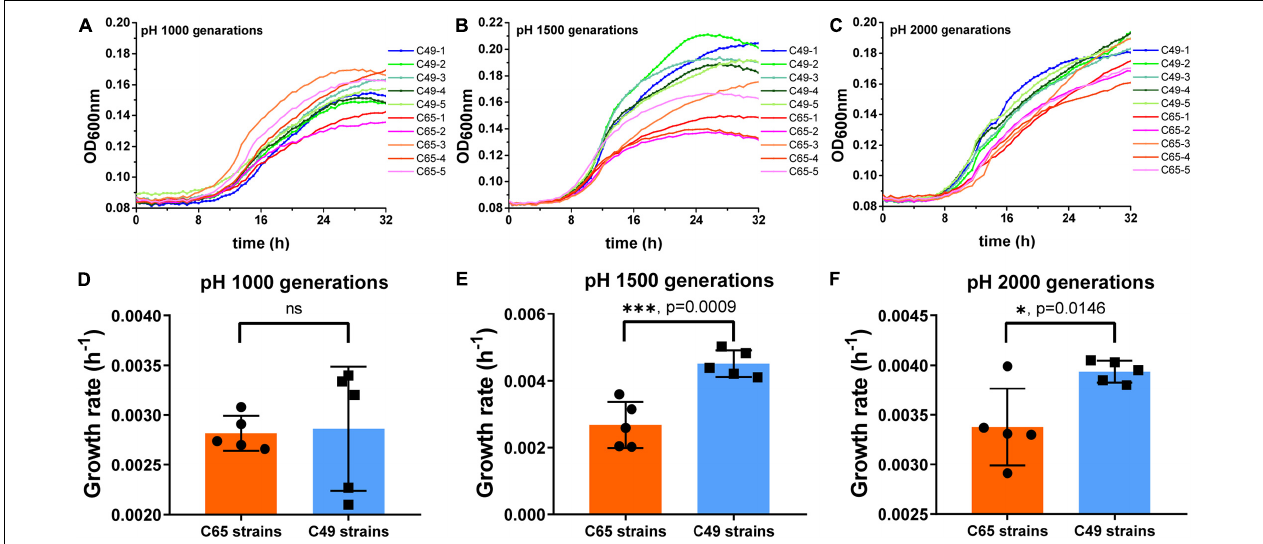
FIGURE 3 | Growth curves and growth rates of 1000, 1500, and 2000 generations in MM medium (pH 4.9). Strains were cultured statically at 30 ◦ C in MM medium at pH 4.9. Bacterial growth was performed in 96-well plates and monitored using a Multiskan GO microplate reader (Thermo Fisher Scientific). The growth rates of each sample within 32 h were determined using the kinetic analysis module of Multiskan GO software. (A–C) Growth curves of 1000 generations, 1500 generations, and 2000 generations, respectively. (D–F) Growth rates of 1000 generations, 1500 generations, and 2000 generations. Asterisks indicate statistical significance (unpaired t